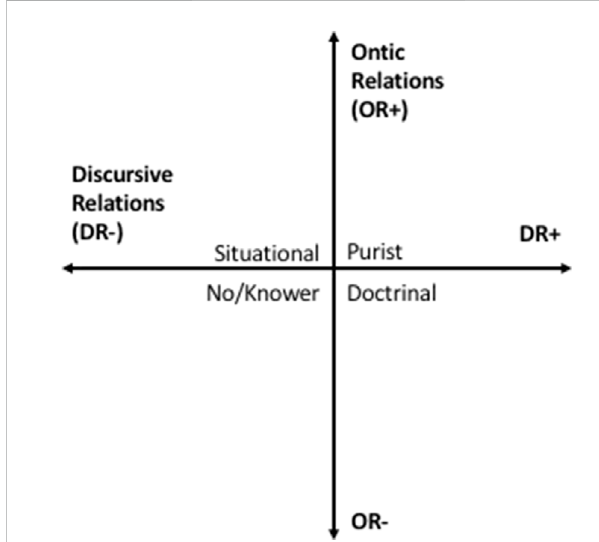
FIGURE 7 The four quadrants described in Legitimation Code Theory which describe the relative importance between ontic relations (whereby a phenonenum can be identi fi ed) and discursive relations (different ways of approaching that phenonenum).